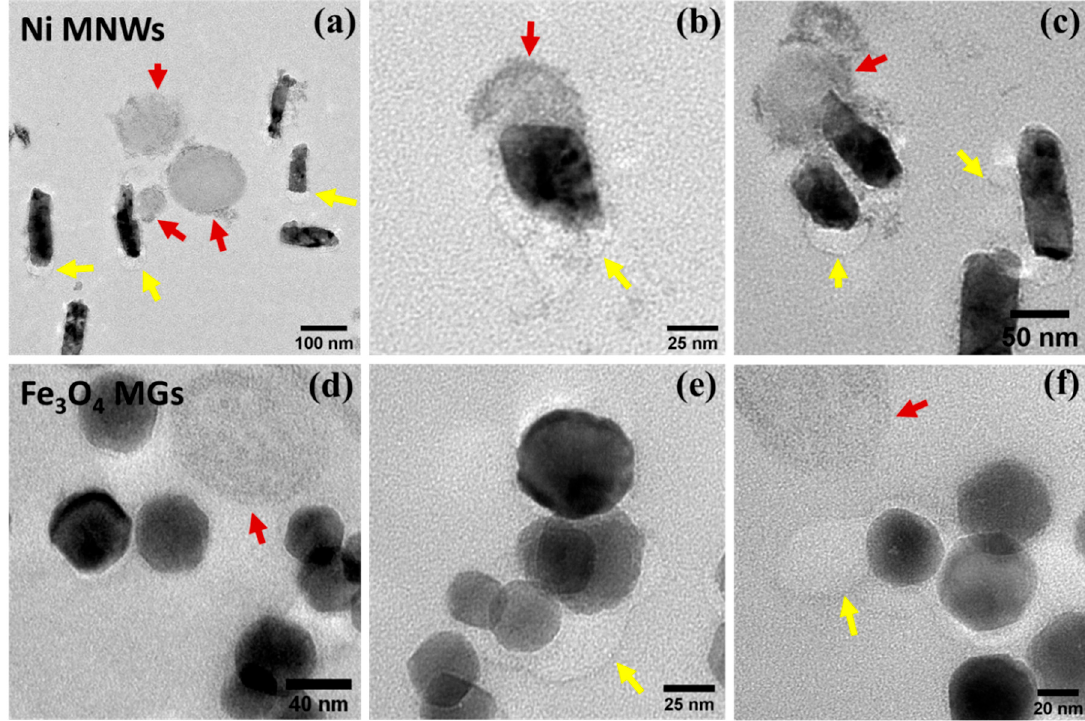
Figure 6. TEM images of vesicles magnetically isolated using ( a – c ) Ni MNWs and ( d – f ) Fe 3 O 4 MGs. Red and yellow arrows have been employed to indicate the presence of different types of released vesicles, as explained in the main text.